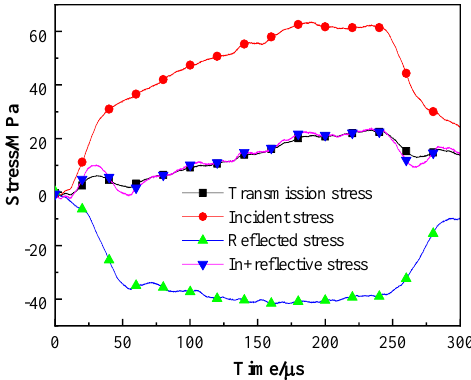
Figure 5. Test piece stress balance inspection.